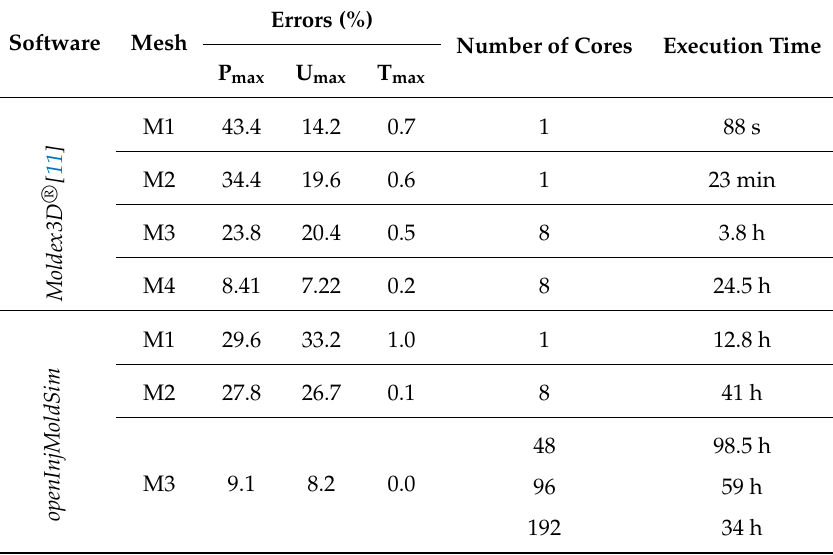
Table 13. General comparison of the accuracy and performance of both openInjMoldSim and (cid:13) Moldex 3 D R